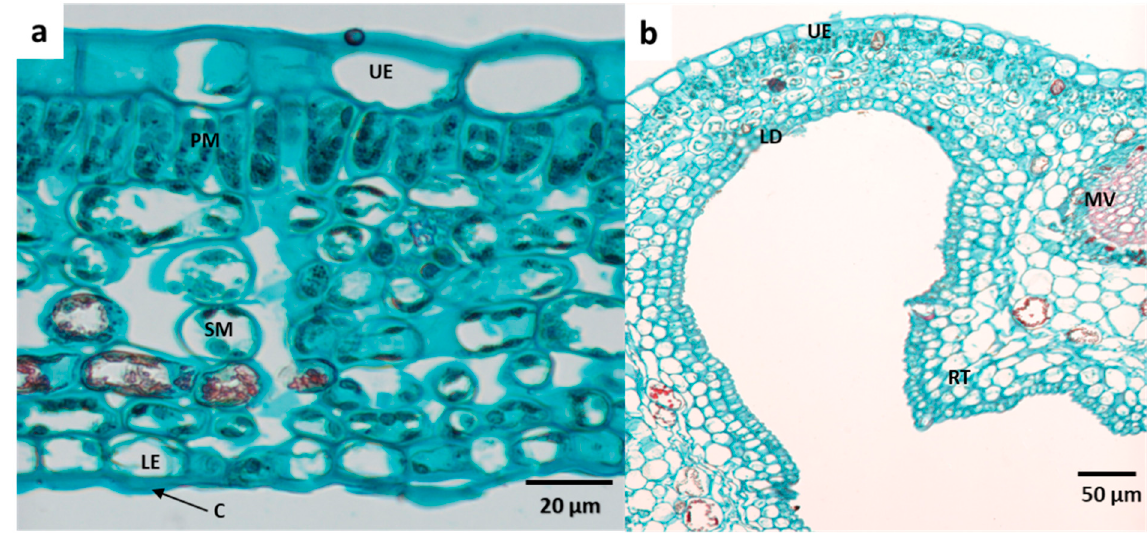
Figure 2. Comparison of domatial and non-domatial tissue of the pouch-type domatia of Rothmannia capensis ; ( a ) non-domatial area of leaf blade, ( b ) domatial tissue with tightly packed cells. C: cuticle, LD: leaf domatial tissue, LE: lower epidermis, MV: mid-vein, UE: upper epidermis, PM: palisade mesophyll layer, RT: rim tissue, and SM: spongy mesophyll layer.